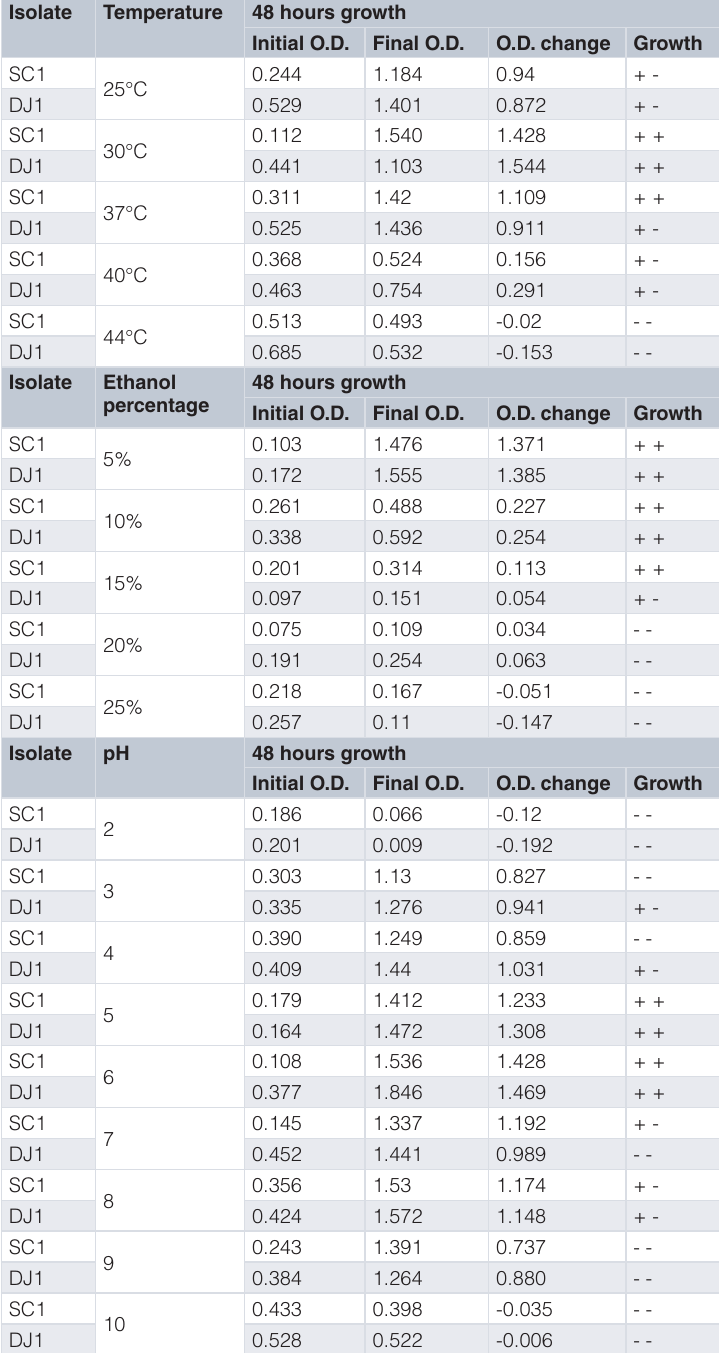
Table 2. Alcohol production in different physical/chemical condition after 48 hours of fermentation. (Legends: + + Positive, + - Variable, -- Negative).